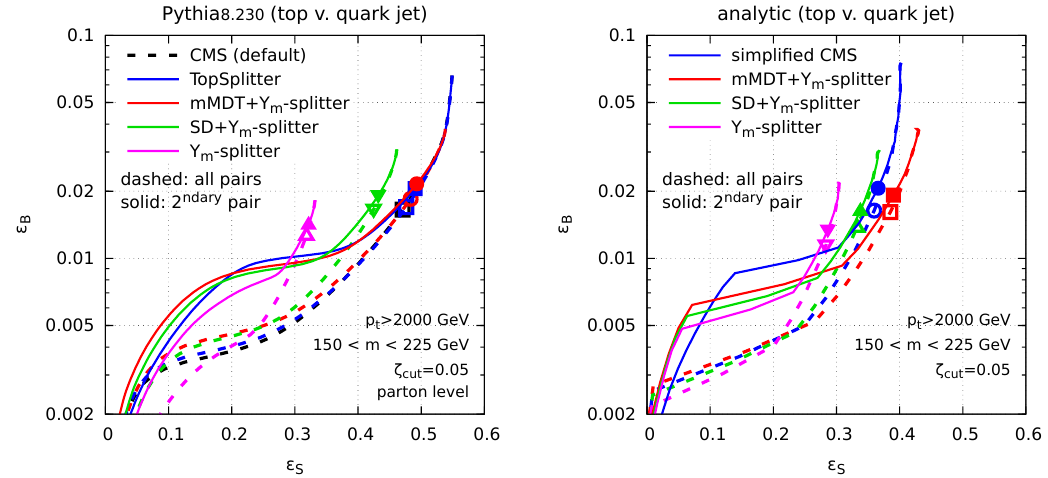
Figure 14. Comparison of the taggers performance when imposing the (cid:26) min condition only on the secondary declustering (solid lines) compared to imposing the (cid:26) min condition on all three pairwise masses (dashed lines). Left: Pythia simulations, right: our analytic